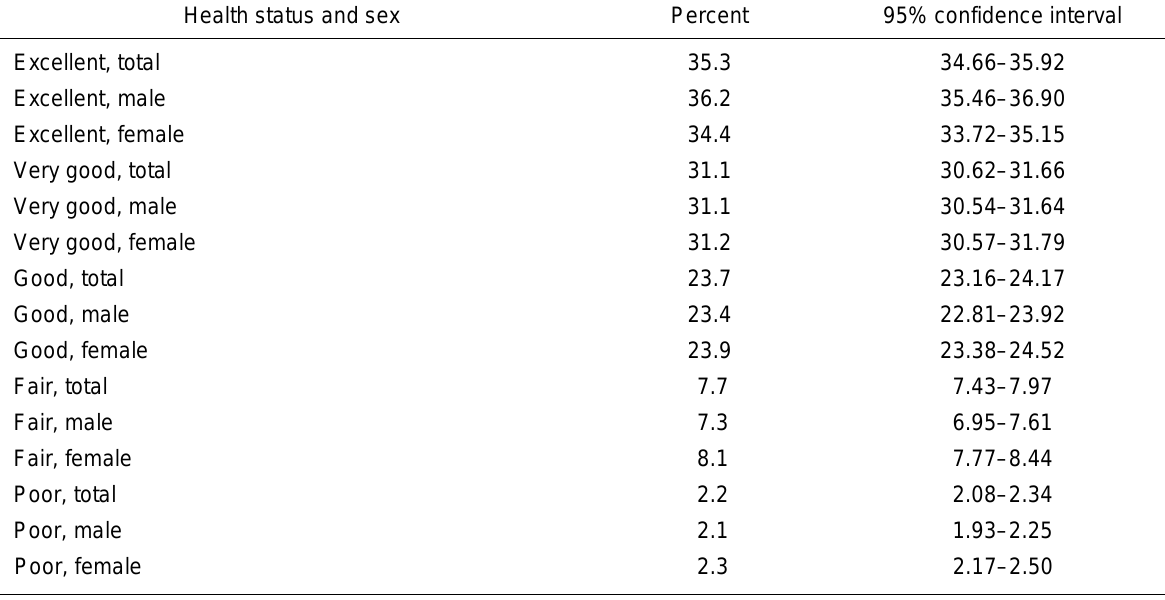
Data table for Figure 11.2. Percent distribution of respondent–assessed